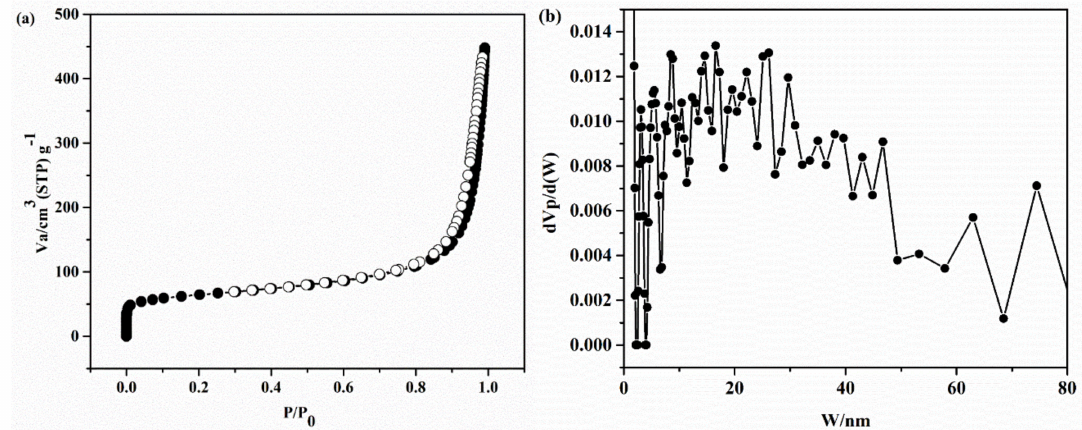
Figure 2. TEM images of sepiolite. ( a ) Bright-field and ( b ) dark-field; scale bars indicate 500 nm.